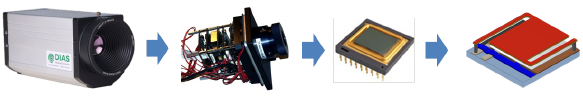
Figure 1. Structure of an uncooled IR camera with microbolome- ters.